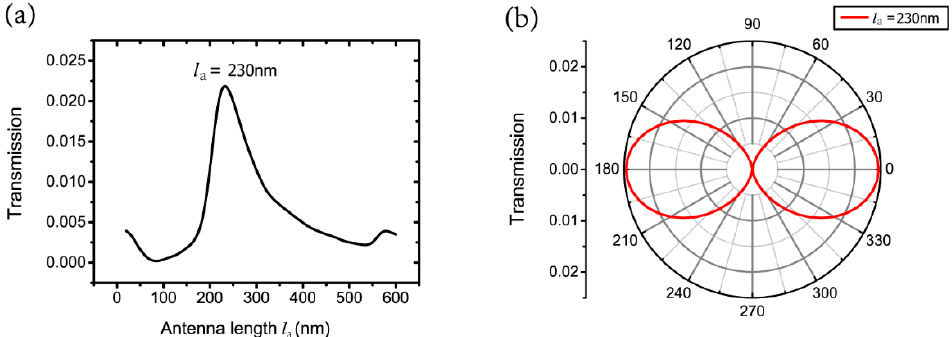
Figure 9. ( a ) Transmission with various antenna lengths of (cid:1864) (cid:2911) under (cid:2019) = 500 nm for TM polarization; ( b ) transmission with different polarization angles at (cid:1864) (cid:2911) = 230 nm under (cid:2019) = 500 nm . ( b ) transmission with di ff erent polarization angles at l a = 230 nm under λ = 500